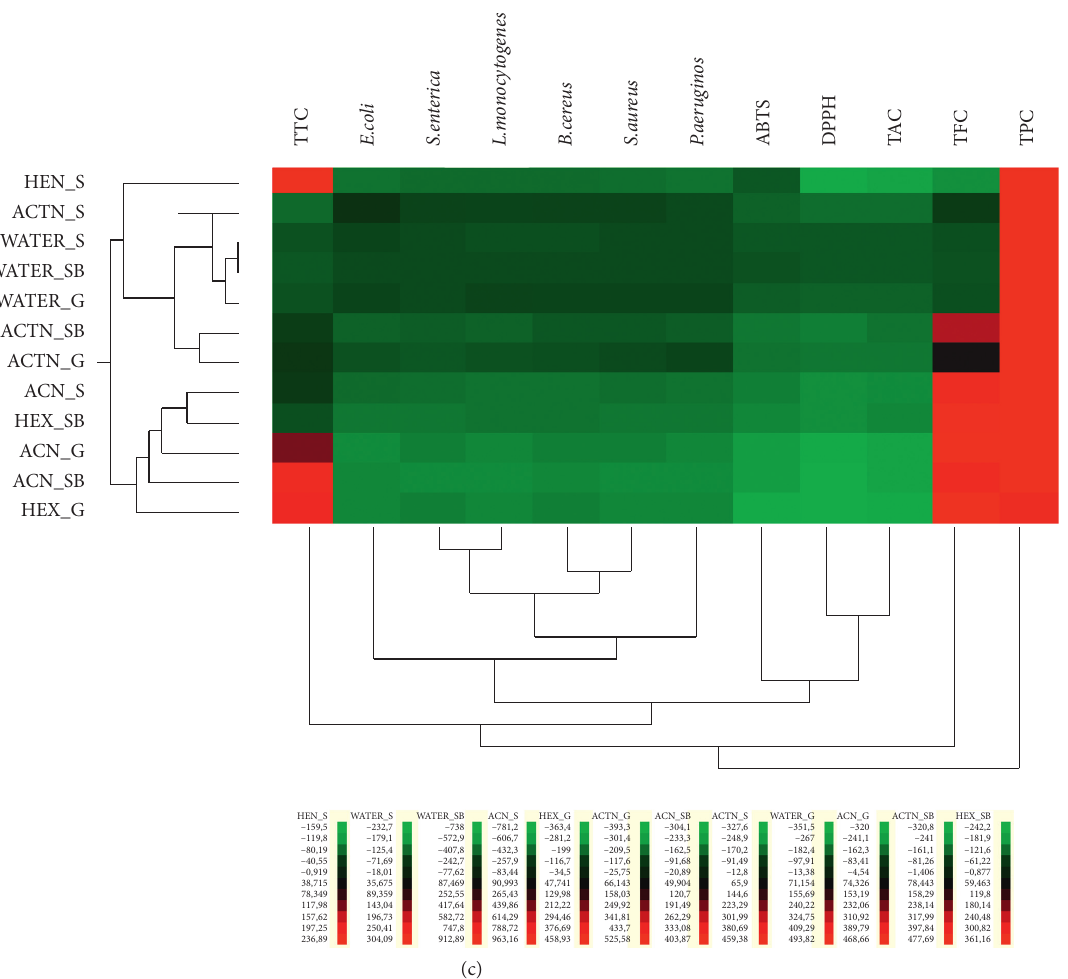
Figure 2: (a). Biplot representation on the factor plane (PC1–PC2) showing vector distribution of phytochemical contents (TPC, TFC, TTC, and TAC), antioxidant (DPPH and ABTS), and antifoodborne bacteria (anti- S. aureus , anti- L. monocytogenes , anti- B. cereus , anti- S. enterica , anti- E. coli, and anti- P. aeruginosa ) activities within score plot of the pistachio hull samples extracted with hexane, acetonitrile, acetone, and water. (b). HCA of phytochemical contents, antioxidant activity, and antifoodborne bacterial activities of different pistachio hull samples extracted with hexane, acetonitrile acetone, and water. (c). Heat map of phytochemical contents, antioxidant activity, and antifoodborne bacterial activities of different pistachio hull samples extracted with hexane, acetonitrile, acetone and